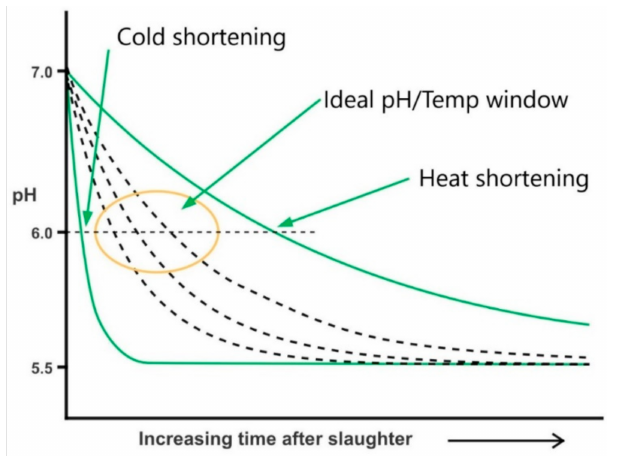
Figure 2. Representation of pH decline ratio over time, highlighting the regions of cold and heat shortening, and the ideal pH/temperature window to produce tender sheep meat. Adapted from